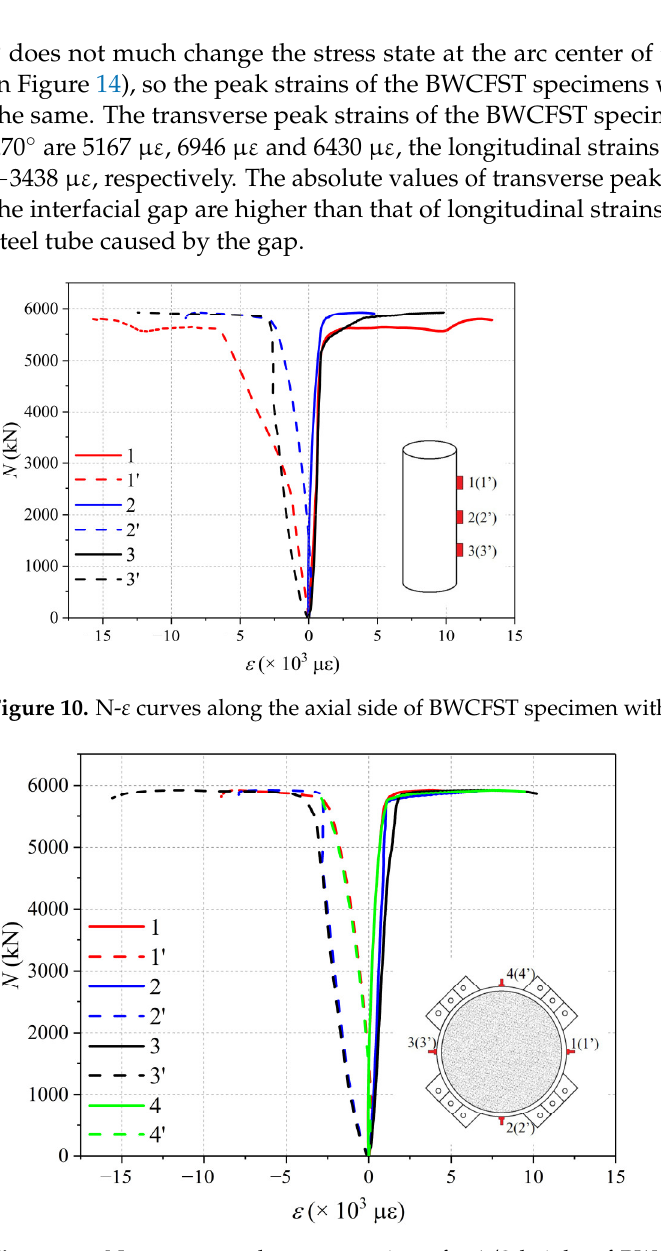
Figure 11. N- ε curves at the cross-section of a 1/2 height of BWCFST specimen without initial imperfection.